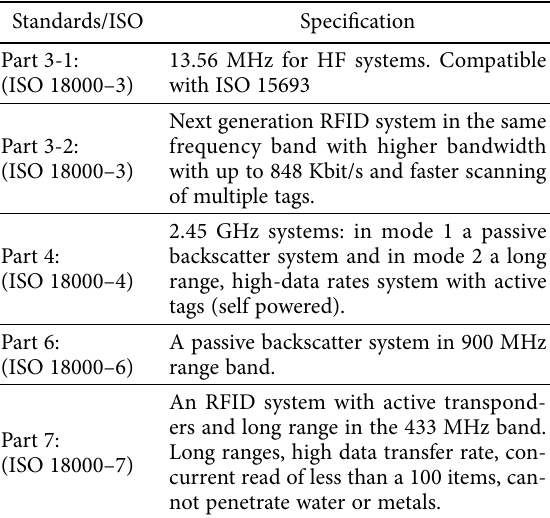
Table 1. The main RFID ISO standards